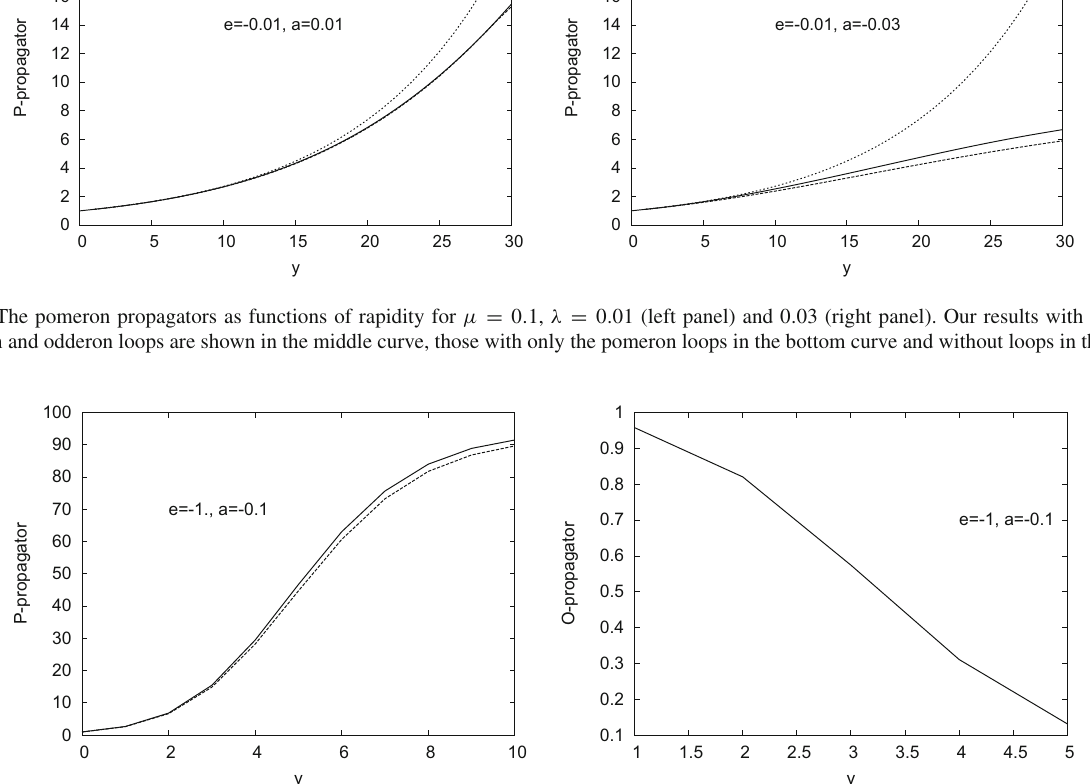
of λ . For λ ≤ 0 . 05 satisfactory results were obtained with N = 400 points in the interval ( 0 , 20 ) for both u and w and 2000 points for (cid:12) y = 1. However, for λ = 0 . 1 we had to raise the precision in y by taking 20,000 points for (cid:12) y =